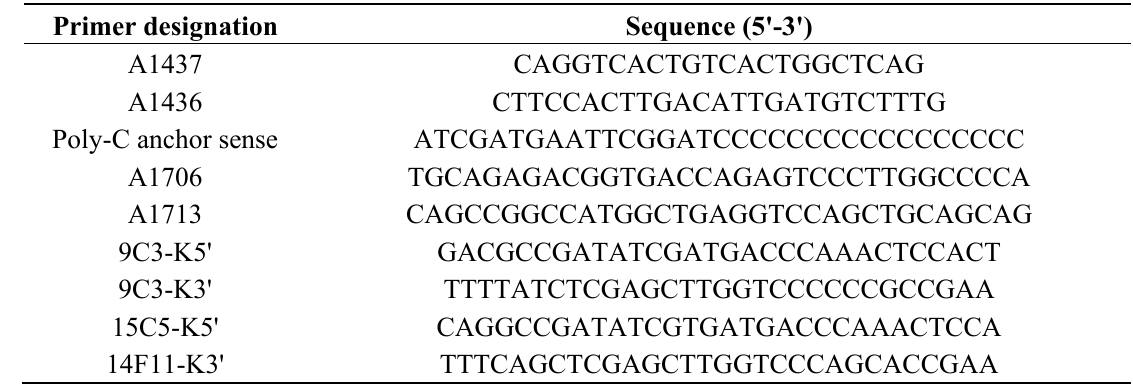
Table 3. Oligonucleotide